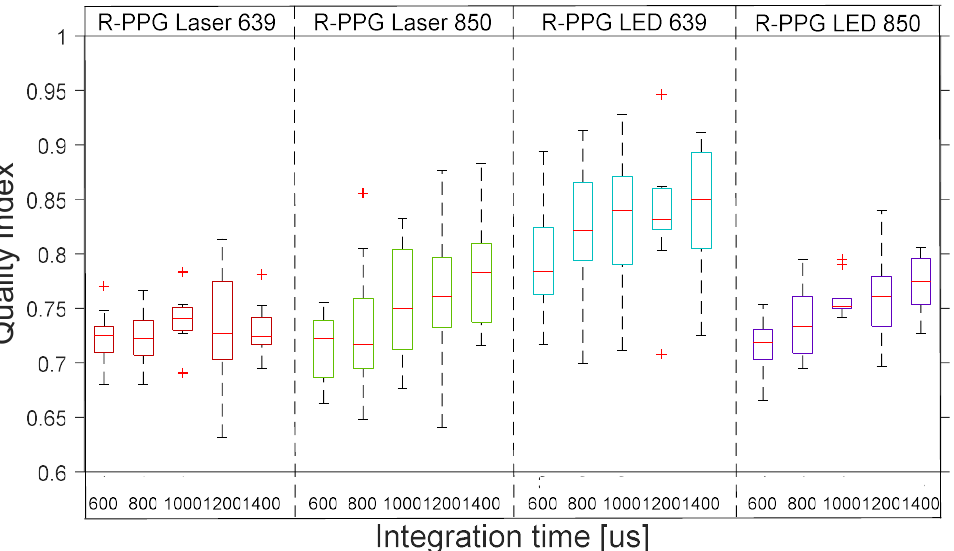
Figure 6. Reflective mode boxplots of quality index for R-rPPG signals with 4 different lights at 5 integration times. The inner box divisions indicate: Q1 (the first quartile) to Q3 (the third quartile). The median is marked by a line across the box. The “whiskers” indicate results from Q1 and Q3 to the most extreme data points. The + and ‡ symbols represent outliers.